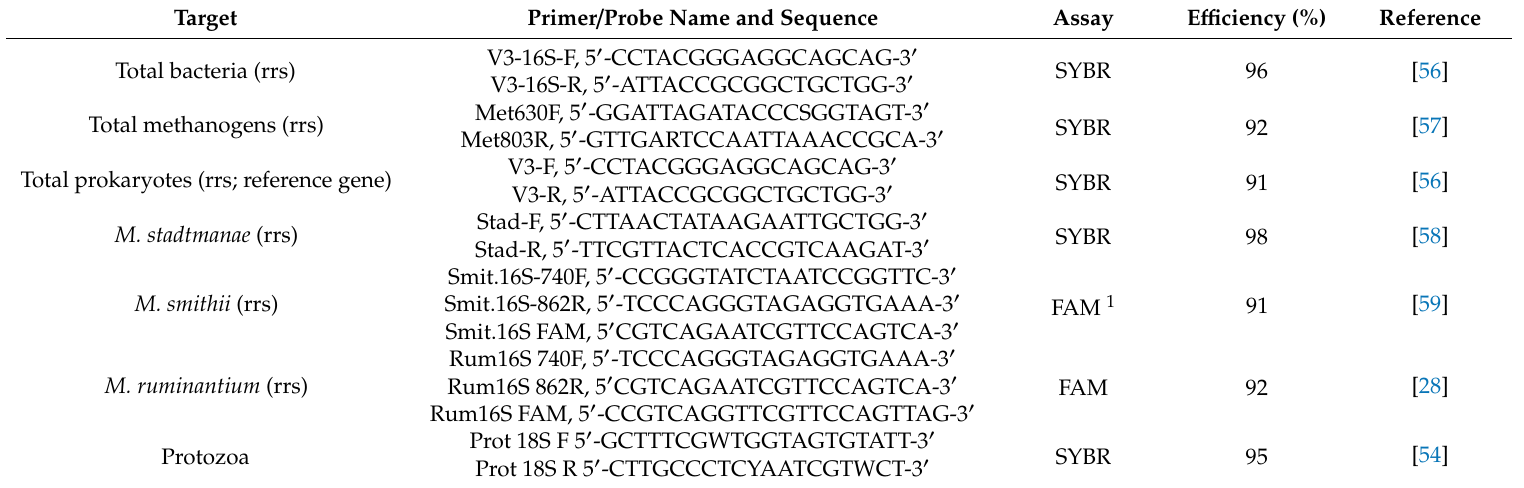
Table 2. PCR primers and probes used for the quantification of ruminal protozoal and methanogenic microbial populations by qPCR